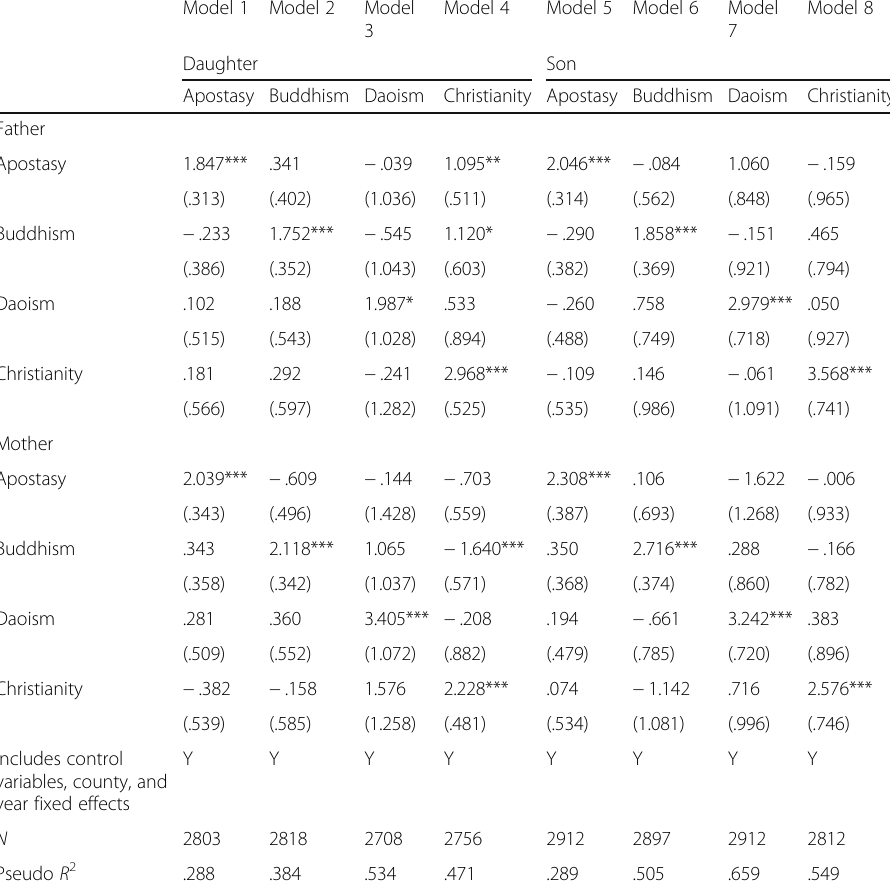
Table 8 Logistic coefficients regressing daughter ’ s and son ’ s religious affiliation on father ’ s and mother ’ s religious